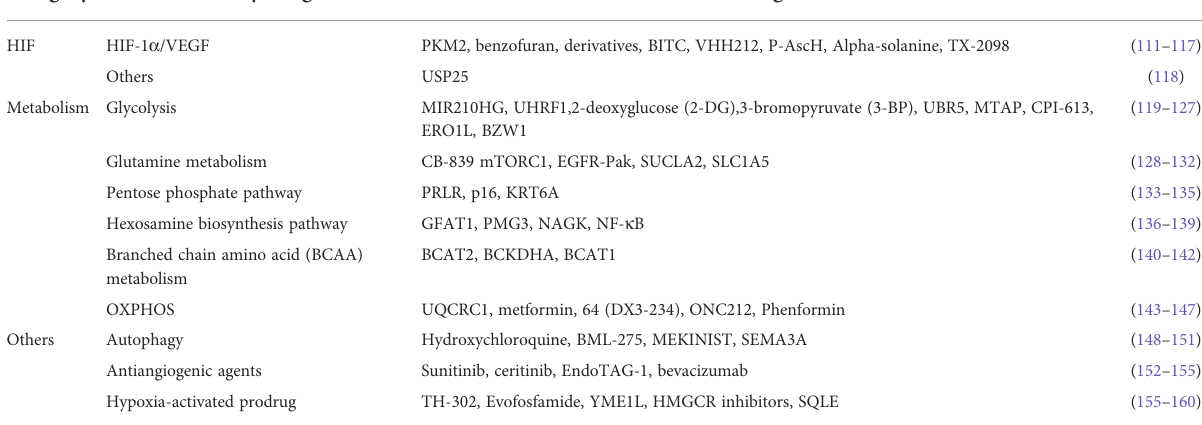
TABLE 1 Target drugs for metabolism, HIF, and other